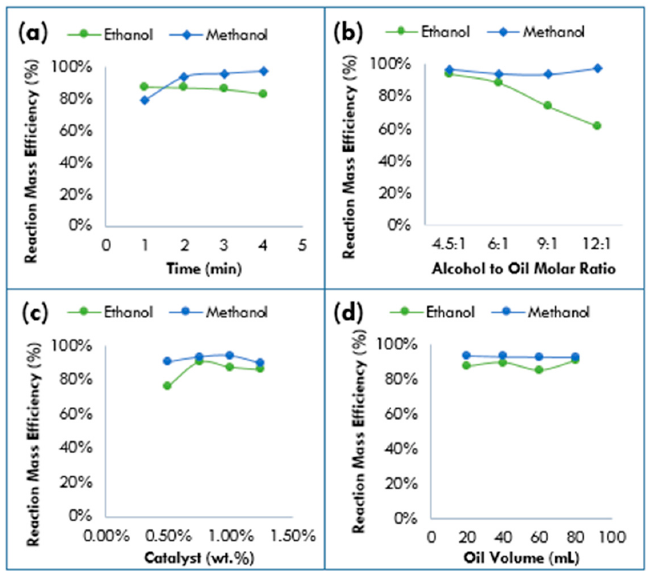
Figure 7. Reaction mass efficiency or Material efficiency for the simultaneous effect of MW/US in WCO transesterification. Effect of ( a ) different reaction time; ( b ) alcohol to oil molar ratio; ( c ) catalyst concentration and ( d ) sample (oil) volume.